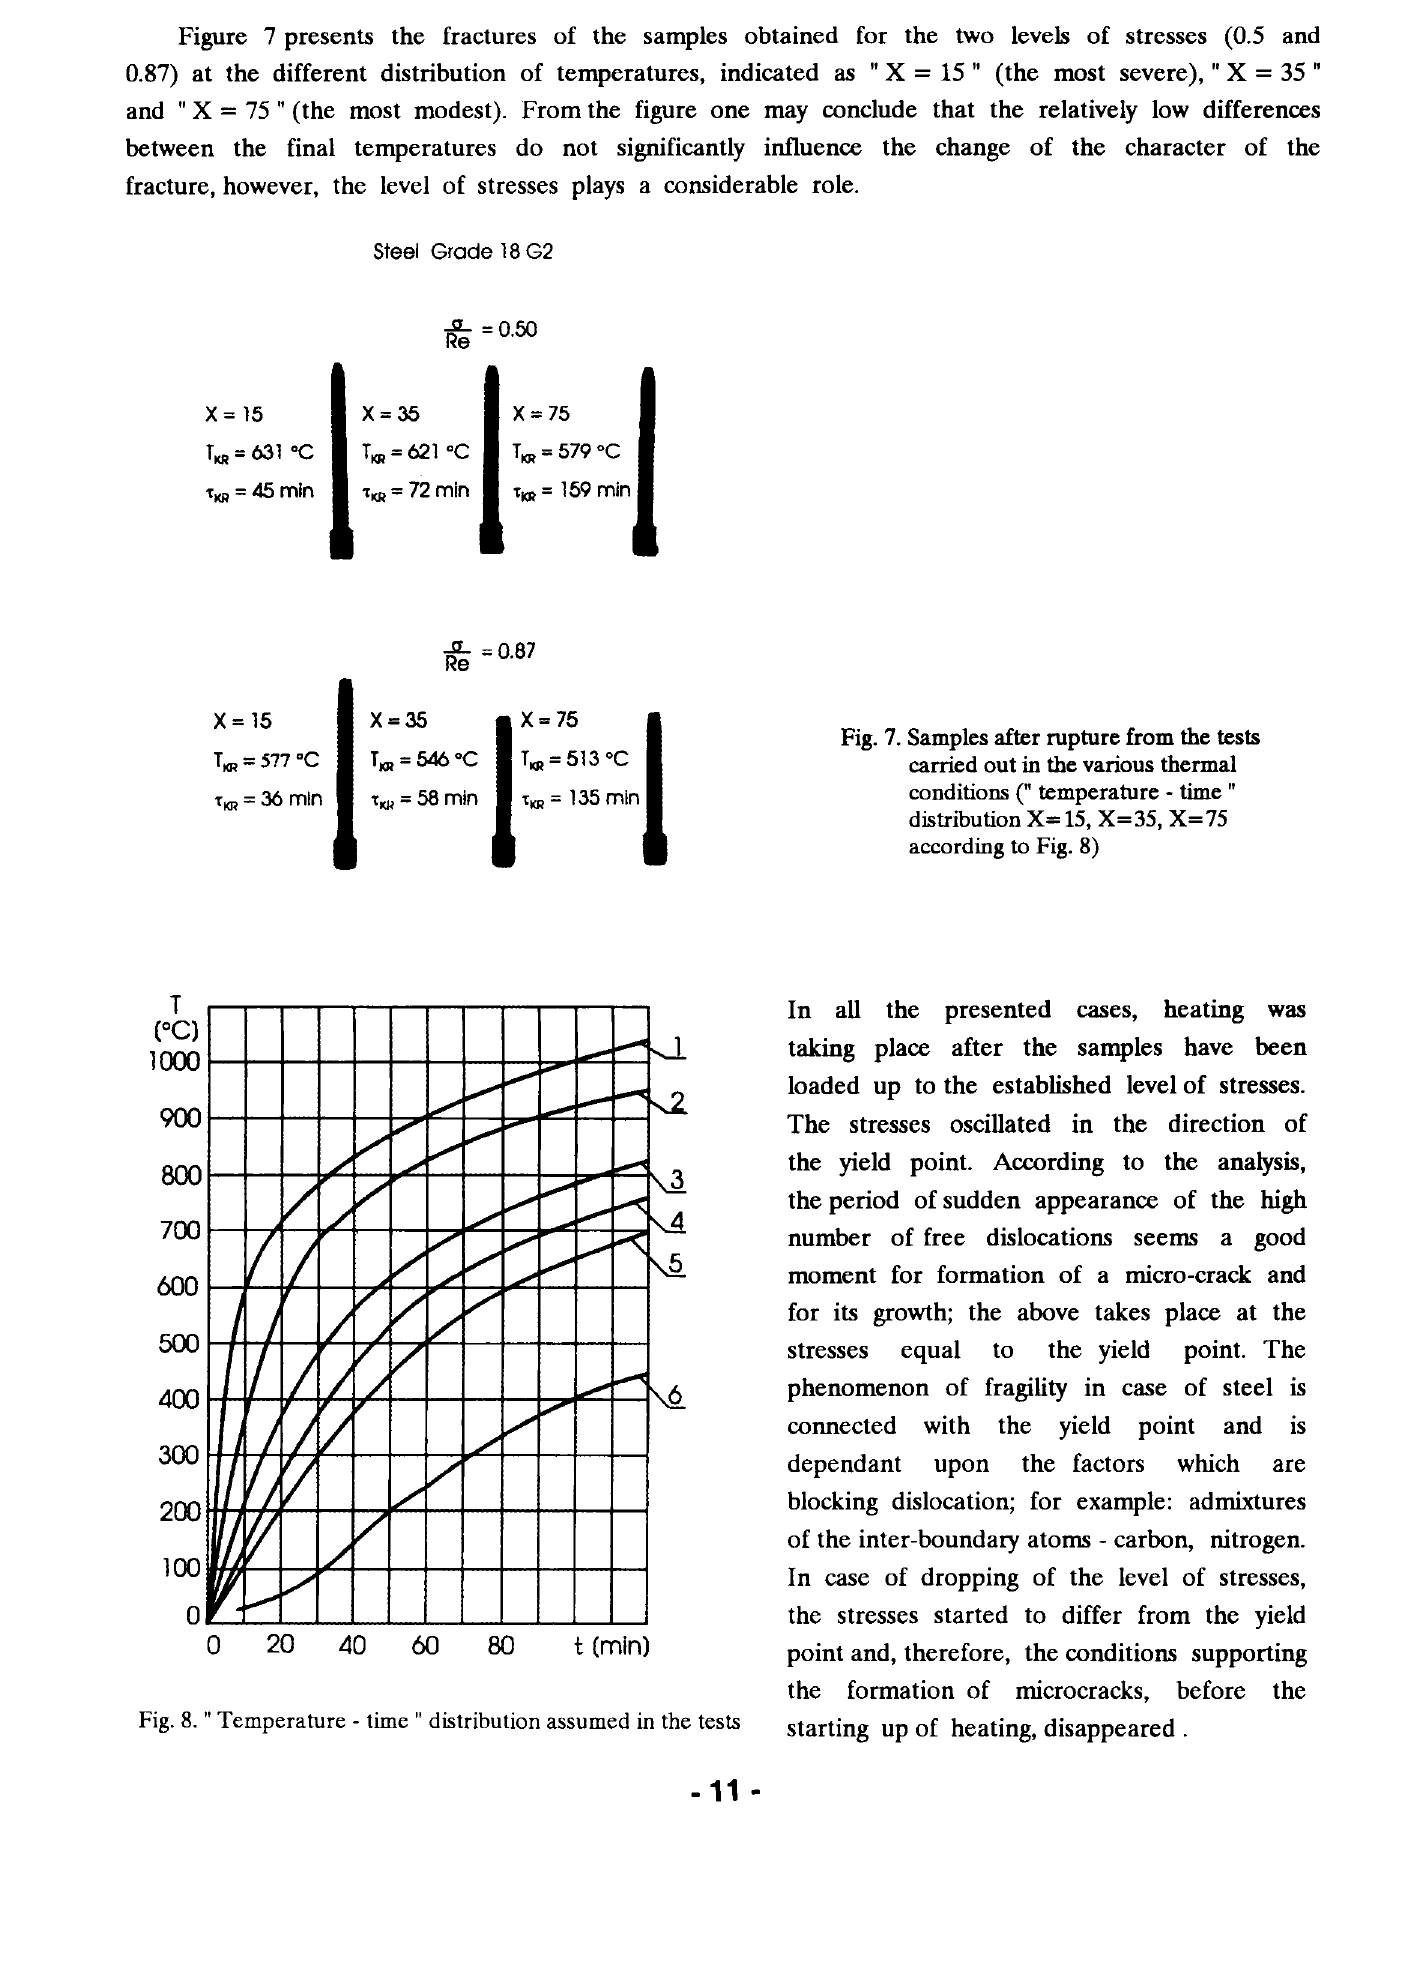
Fig. 8. " Temperature - time " distribution assumed in the tests